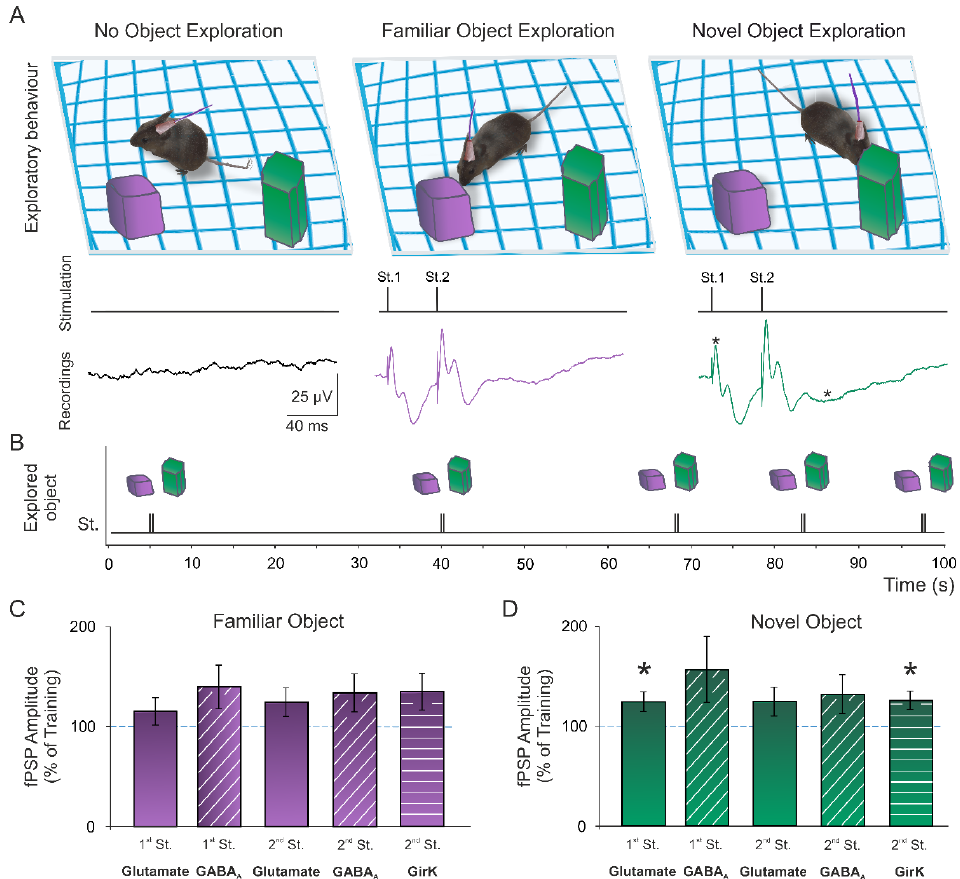
Figure 2. Memory-induced synaptic plasticity. ( A ) During the novel object recognition (NOR) session, animals were stimulated in the Schaffer collaterals with paired pulses (40-ms interstimulus interval) when displaying an exploratory behavior towards either the familiar or novel object. ( B ) Pulses were applied in alternate exploratory events, with a minimum of 10 s between stimulation. The response evoked in CA1 was recorded for amplitude analysis. ( C , D ) Graphs represent the mean ± standard error of the amplitude of fEPSPs and fIPSPs evoked in the CA1 area by electrical stimulation during the NOR session when mice explored the familiar (( C ); n = 21) and the novel object (( D ); n = 22). All data were normalized as a percentage of the values recorded during the training session. *, p < 0.05 vs. training (100%). St., stimulus.